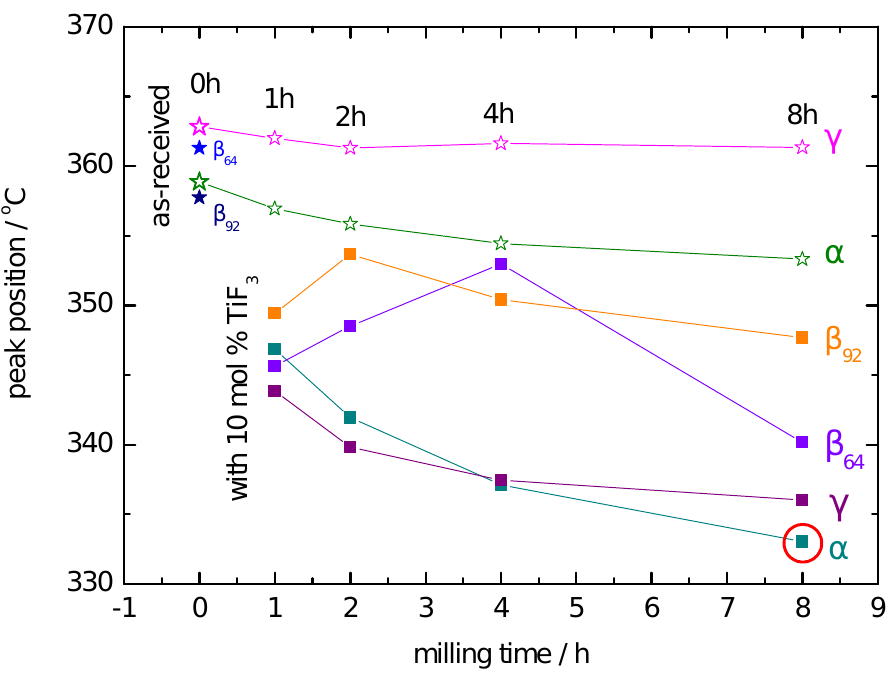
Figure 6. Position of the decomposition peaks as observed by DSC. The lowest decomposition temperature corresponds to α βγ + 10 mol% TiF 3 milled for 8 h and is marked by a red circle. 0 h means the sample was measured as-received.